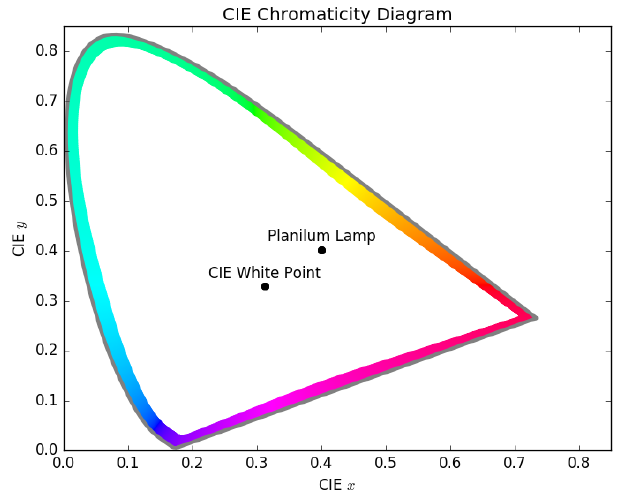
Figure 4. The CIE 1931 color space chromaticity diagram of the standard lamp.